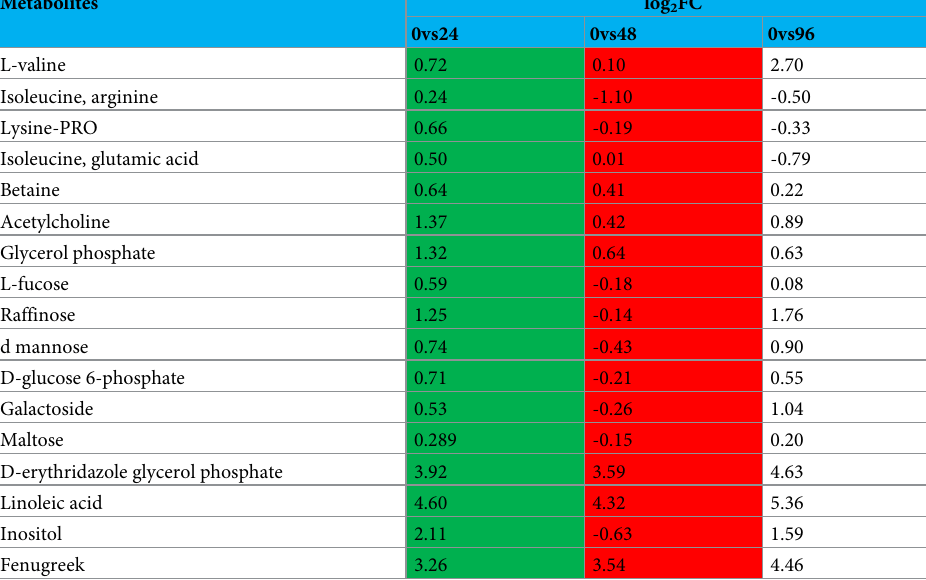
Table 5. Expression of differentially expressed metabolites.